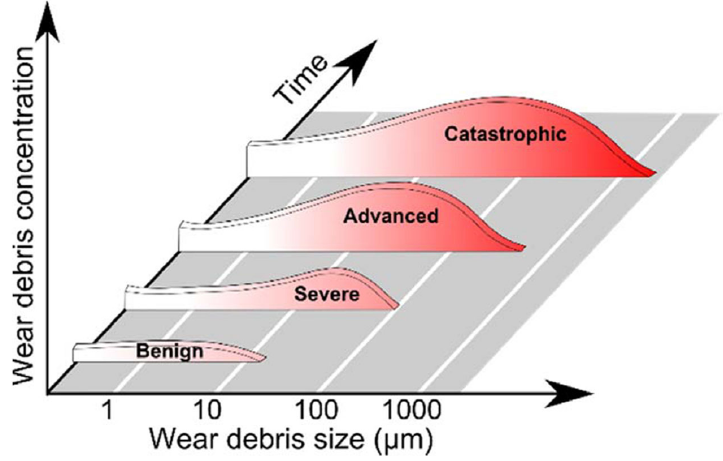
Figure 1. The relationship between the size and concentration of wear particles and the wear state of rotating parts.